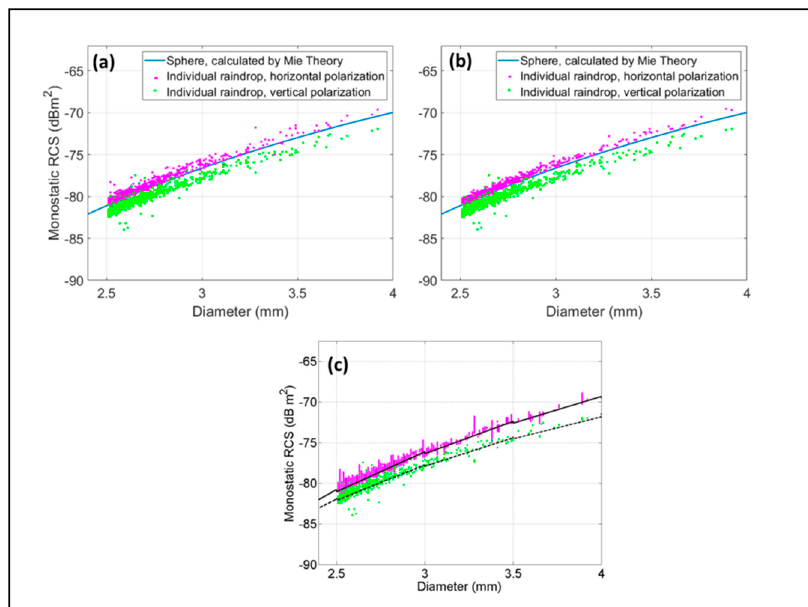
Figure 4. Radar Cross Section (RCS) of 601 reconstructed raindrops for horizontal and vertical polarization, as a function of their respective equal volume diameter. For comparison, the RCS of a sphere is shown. f = 5.625 GHz and the refractive index m = 8.6137 ‐ j1.3020. Panel ( a ) is for a fixed view angle of φ = 0, and panel ( b ) is the averaged value of the RCS over φ = 0 to 359°. Panel ( c ) shows the same RCS versus D eq as panel ( b ) for the reconstructed drops for H and V polarizations, compared with those assuming the BC model is included (solid line, respectively, dashed line are for H,V polarizations).